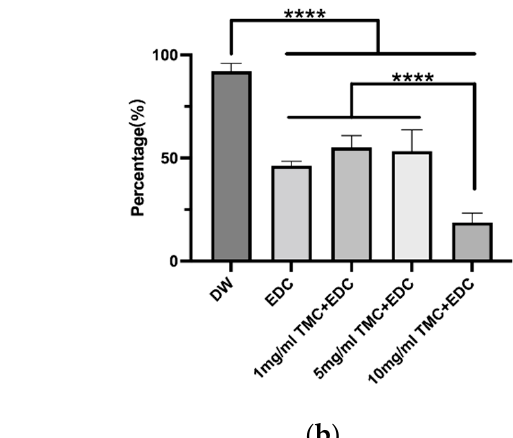
Figure 5. ( a ) Elastic modulus of each group after different treatment methods; ( b ) Degradation percentage of elastic modulus after collagenase degradation. (****, p < 0.0001.)